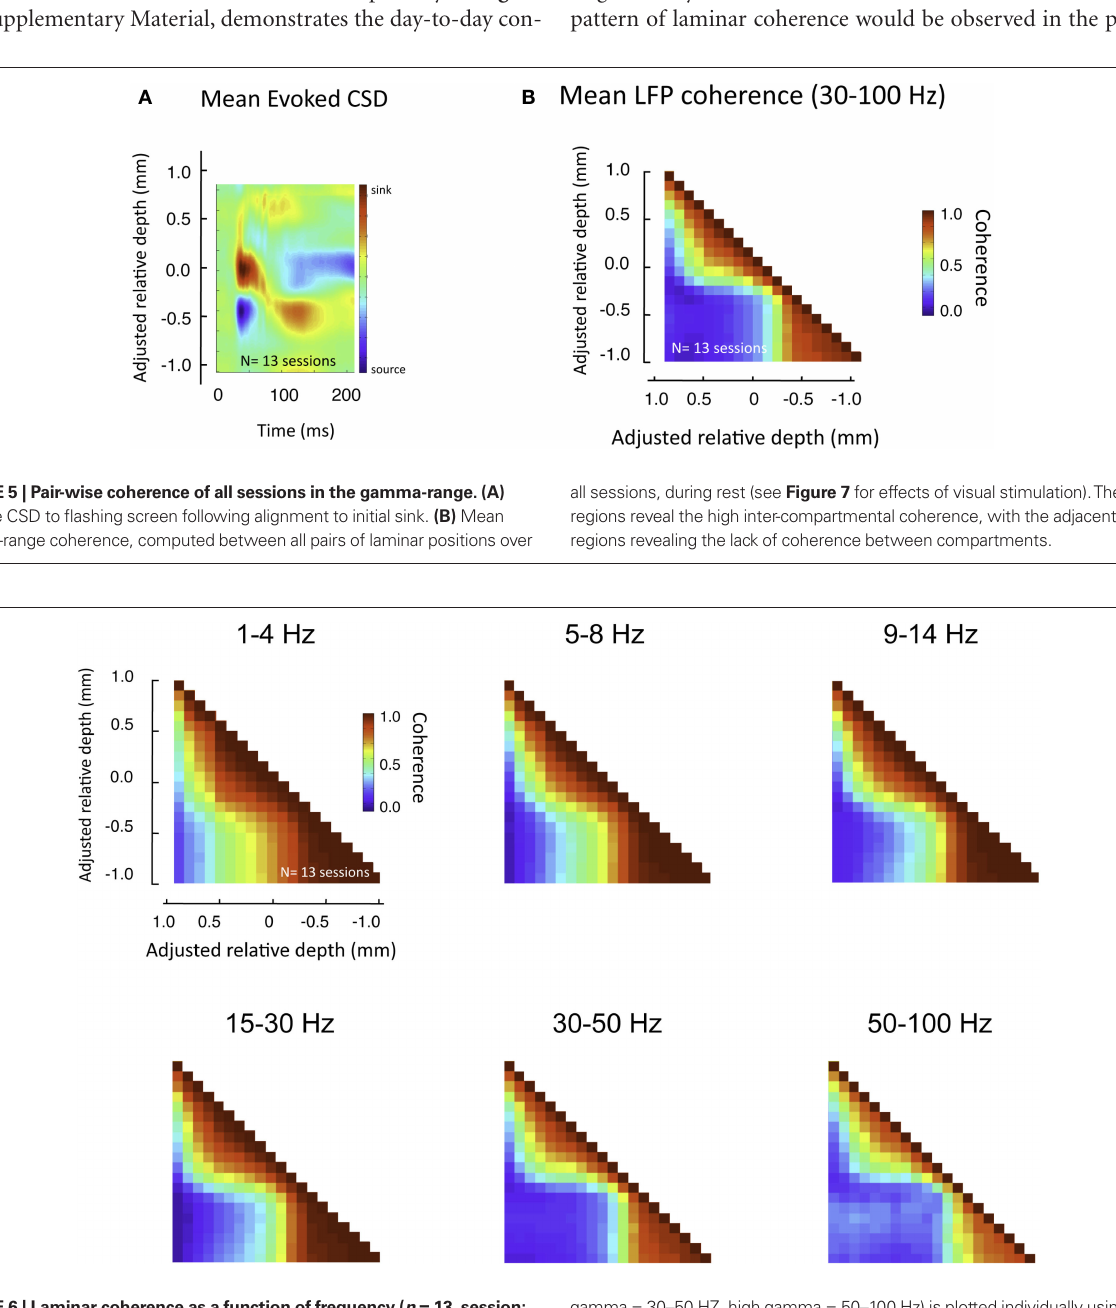
Figure 6 | Laminar coherence as a function of frequency ( n = 13, session; both monkeys). Inter-compartmental coherence for the classic EEG frequency bands (delta = 1–4 Hz, theta = 5–8 Hz, alpha = 9–14 Hz, beta = 15–30 Hz, low